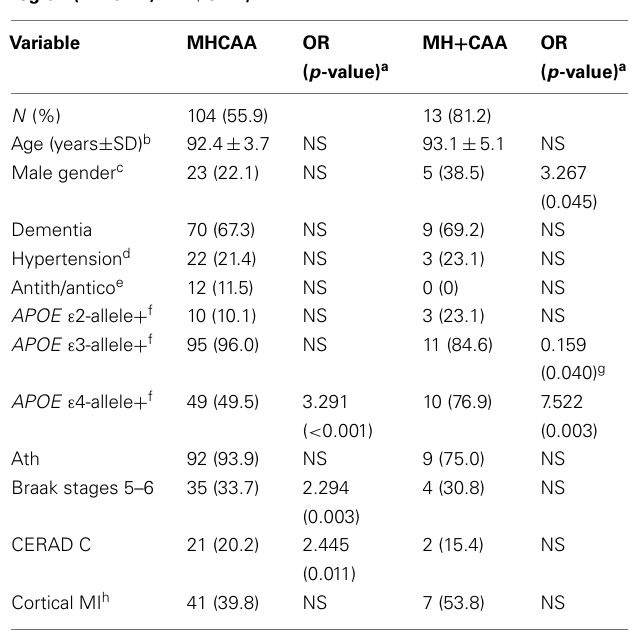
Table 3 | Characteristics of subjects with microscopic brain hemorrhage (MH, MH + ) concomitantly with CAA in the same brain region (MHCAA, MH + CAA).